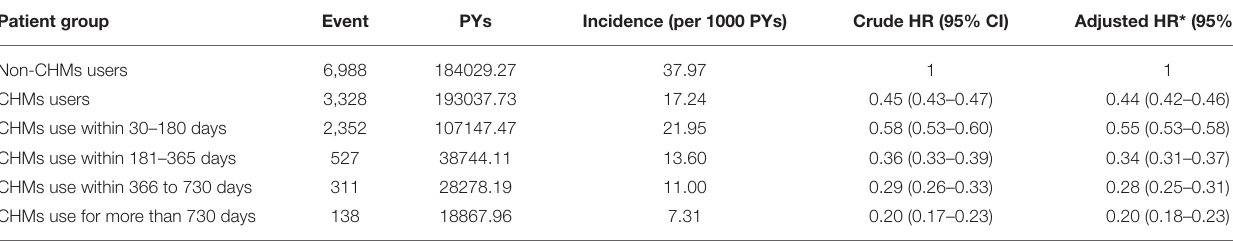
TABLE 2 | Risk of depression for insomnia subjects with and without CHMs.